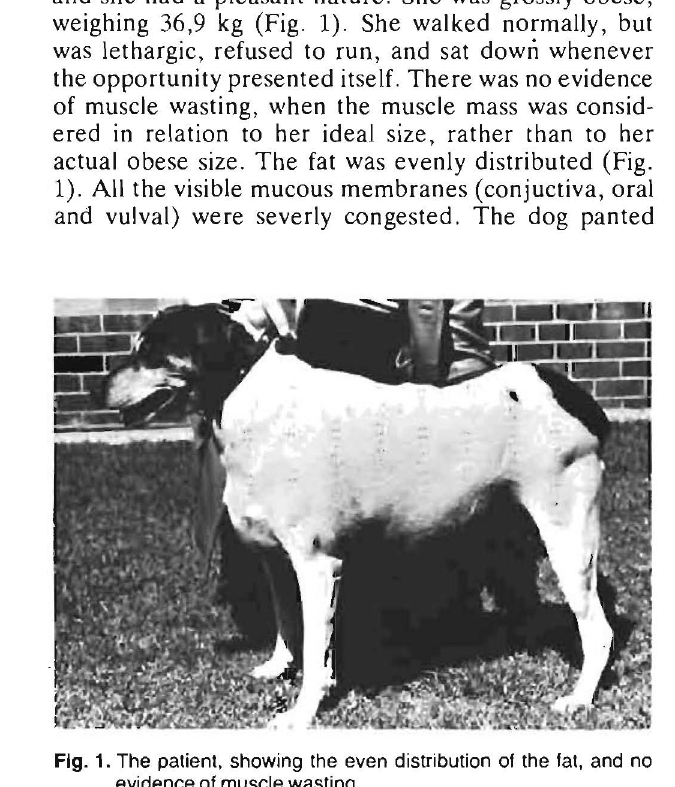
Fig. 1. The patient, showing the even distribution of the fat, and no evidence of muscle